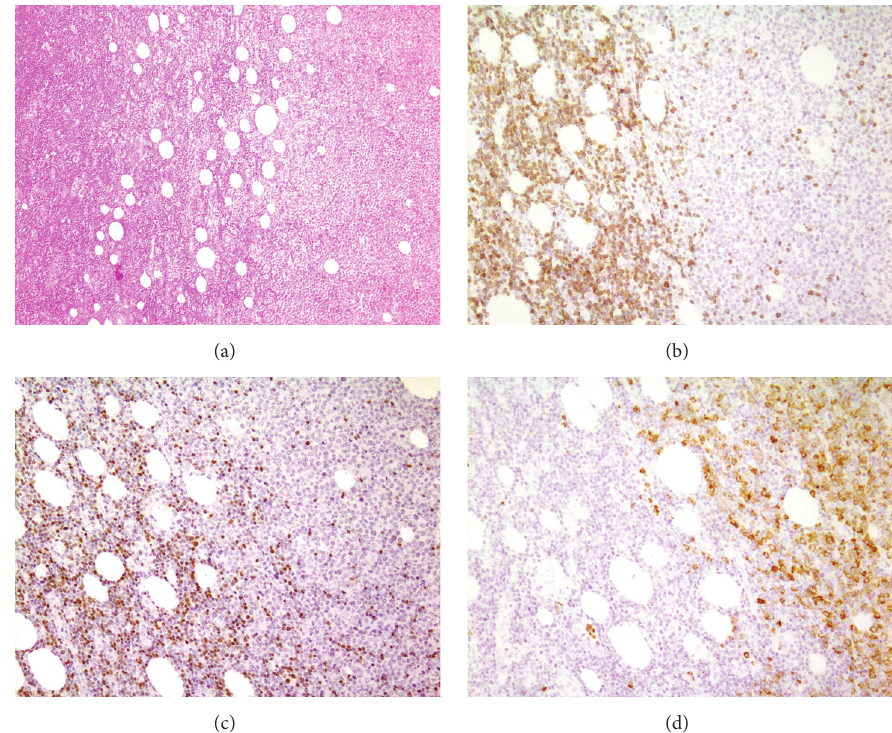
Figure 1: (a) Histologic section of lymph node showed effaced architecture by infiltration of bipopulation of blastoid cells (H&E stain × 100). (b) Positive immunostaining for CD3 in one population of blastoid cells (counterstain with hematoxylin × 400). (c) Positive immunostaining for tdt in the same population of blastoid cells (counterstain with hematoxylin × 400). (d) Positive immunostaining for MPO in another population of blastoid cells (counterstain with hematoxylin × 400).